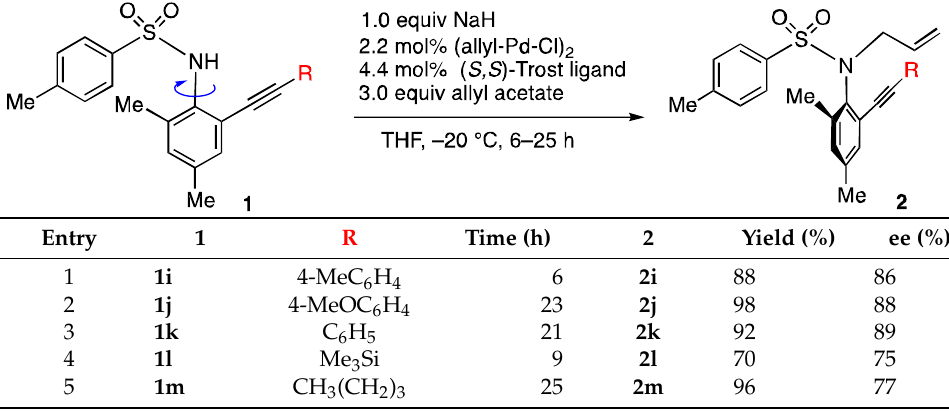
Table 2. Substituent effect on alkynyl group in enantioselective N